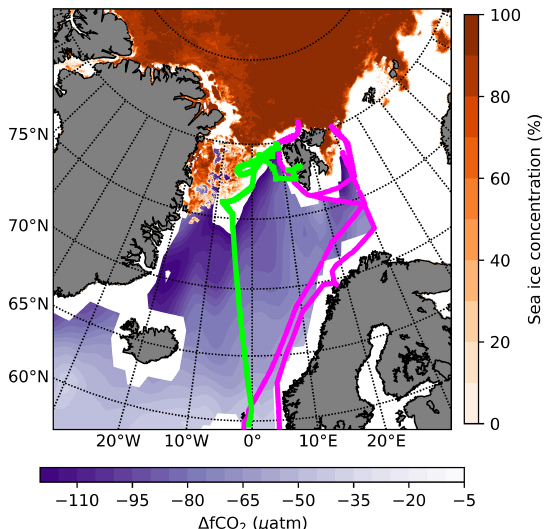
Figure A1. Cruise tracks of JR18006 (magenta) and JR18007 (green). The bottom colour bar indicates the CO 2 fugacity difference ( (cid:49)f CO 2 ) of August 2019 (Bakker et al., 2016; Landschützer et al., 2020), while the right colour bar shows the Arctic sea ice concentrations of 1 August